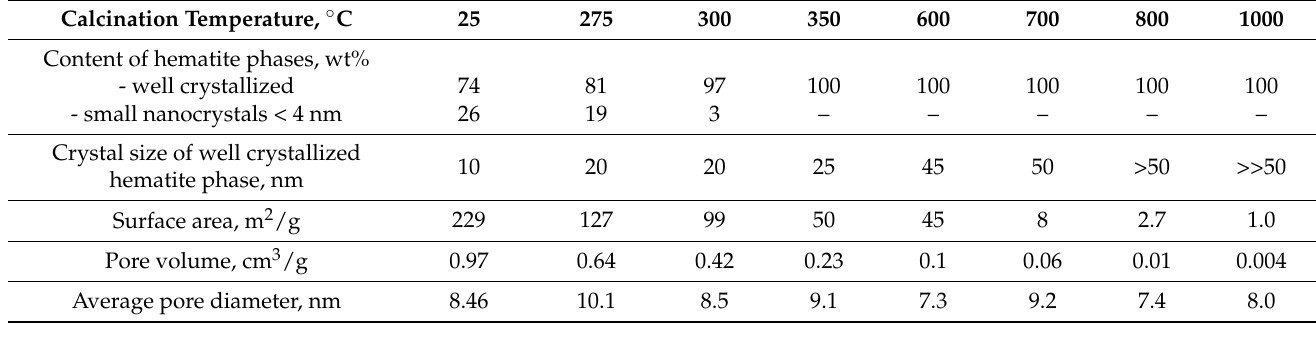
Table 1. Effect of calcination temperature on the texture parameters of pure hematite core.